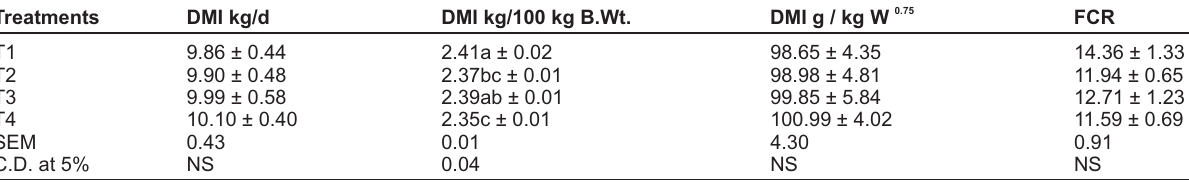
Table-3. Dry matter intake and feed conversion efficiency of experimental heifers